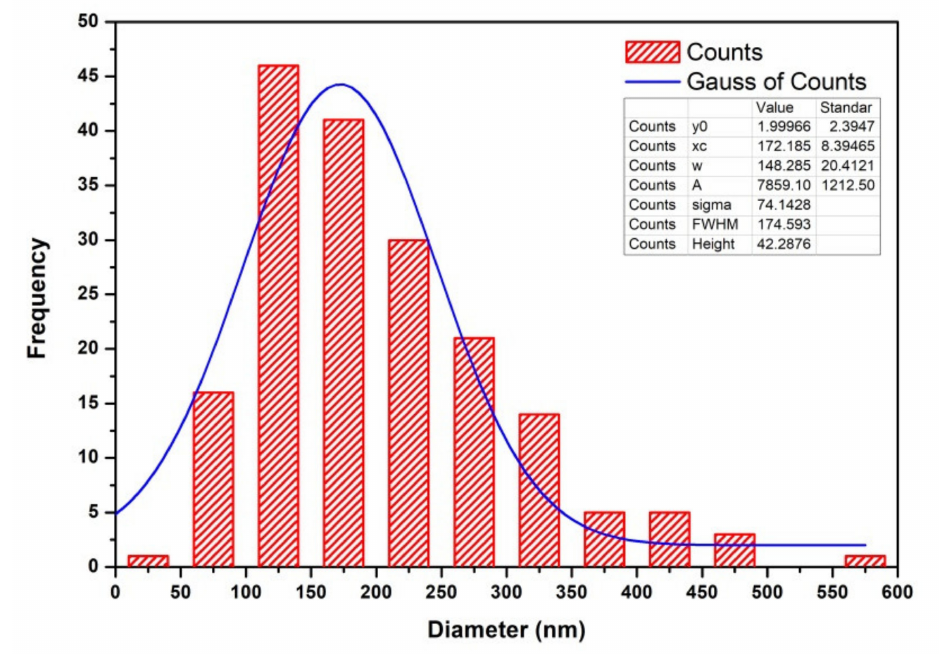
Figure 8. The histogram curve of CNFs diameter